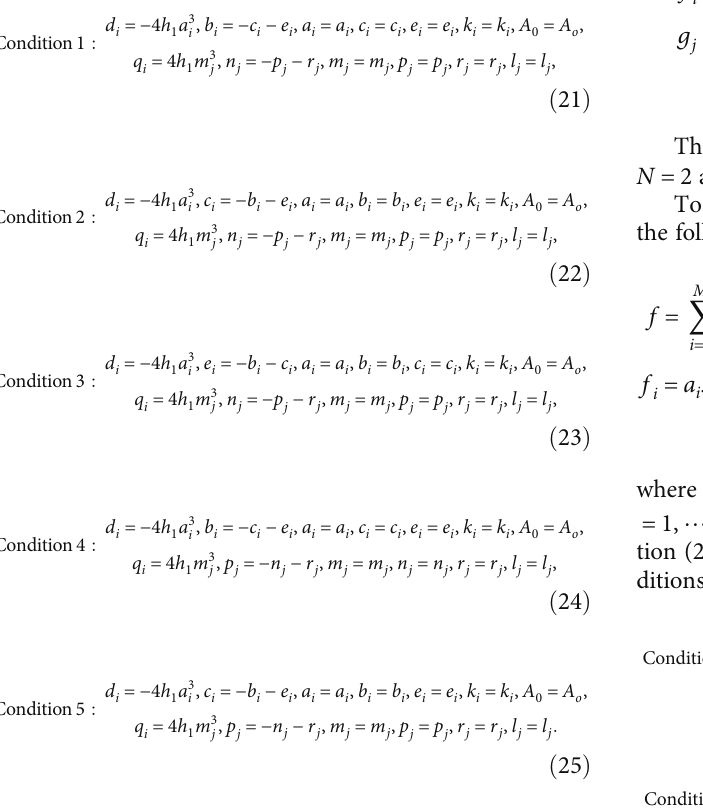
= h = e = c = a = r = k = k = k = 1, c = a = p = l = l = 2, 1 2 1 2 2 2 1 2 3 1 3 1 2 1